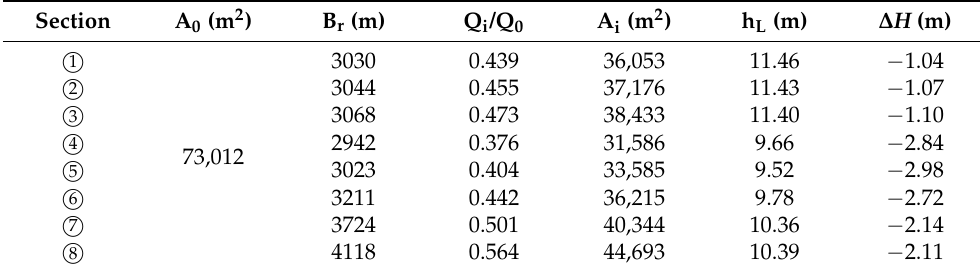
Table 2. Equilibrium water depth of the North Passage after the